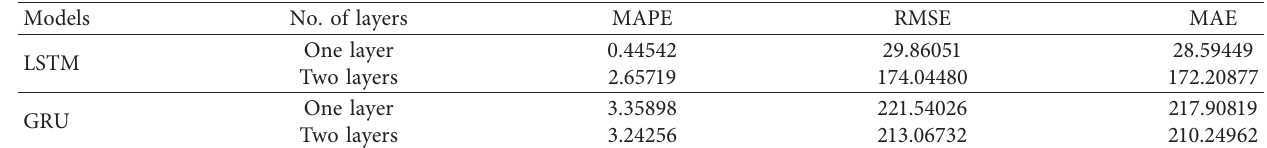
Table 5: The results of DL for death cases in Egypt.